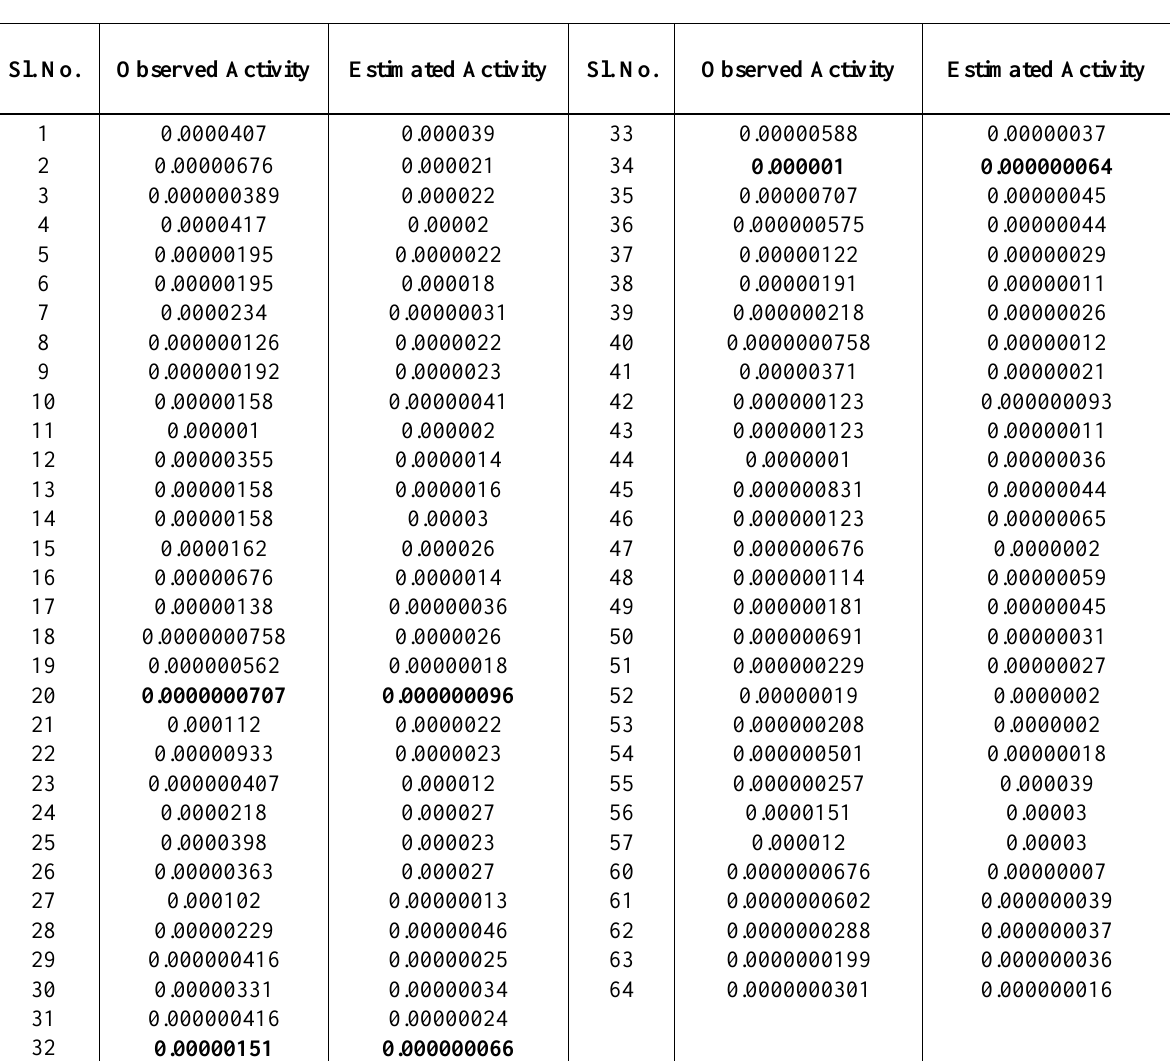
Table II : All the molecules in the training and test set with observed and estimated activities are shown. All test set molecules are given in bold.